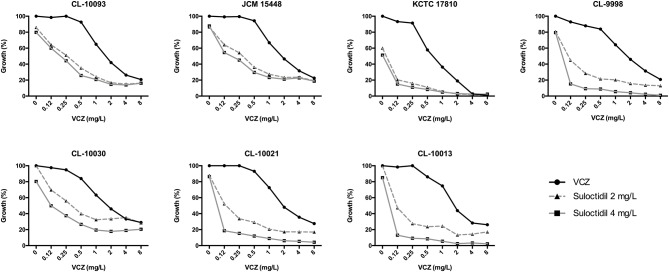
Representative graphs of the synergistic effect of VCZ (ranging concentration: 8–0.12 mg/L) in combination with 2 and 4 mg/L of suloctidil against C. auris strains by checkerboard assay.